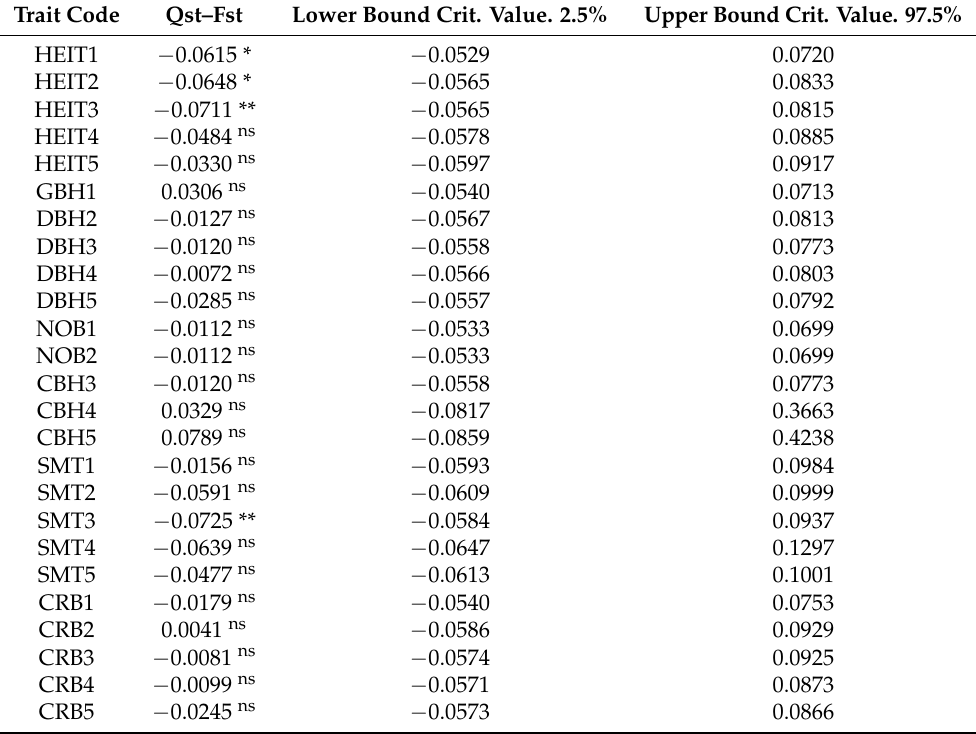
Table 5. Comparison of the Q ST values of traits with the F ST values of microsatellite alleles in different populations.